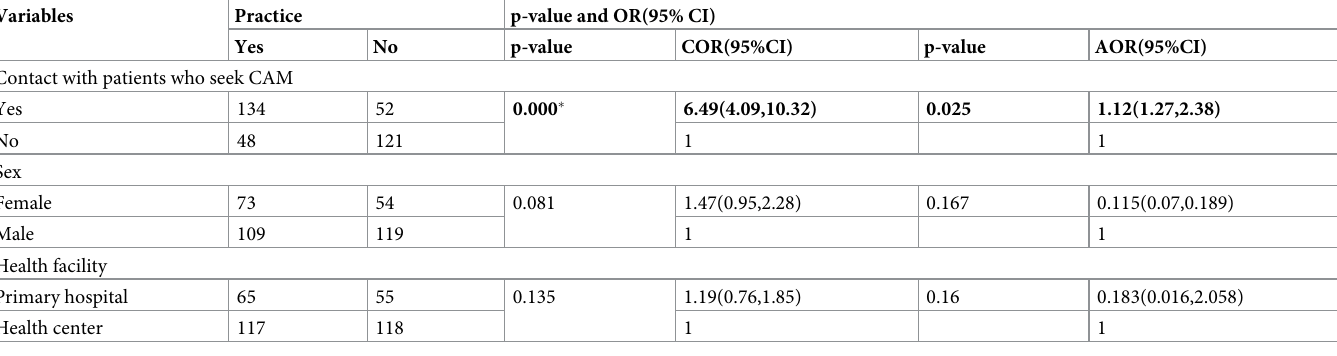
Table 5. Bivariate and multivariable analysis of factors associated with practice towards complementary and alternative medicine among health care professionals in selected primary health care unit in Hadiya Zone, Southern Ethiopia, April, 2021 (n = 355).